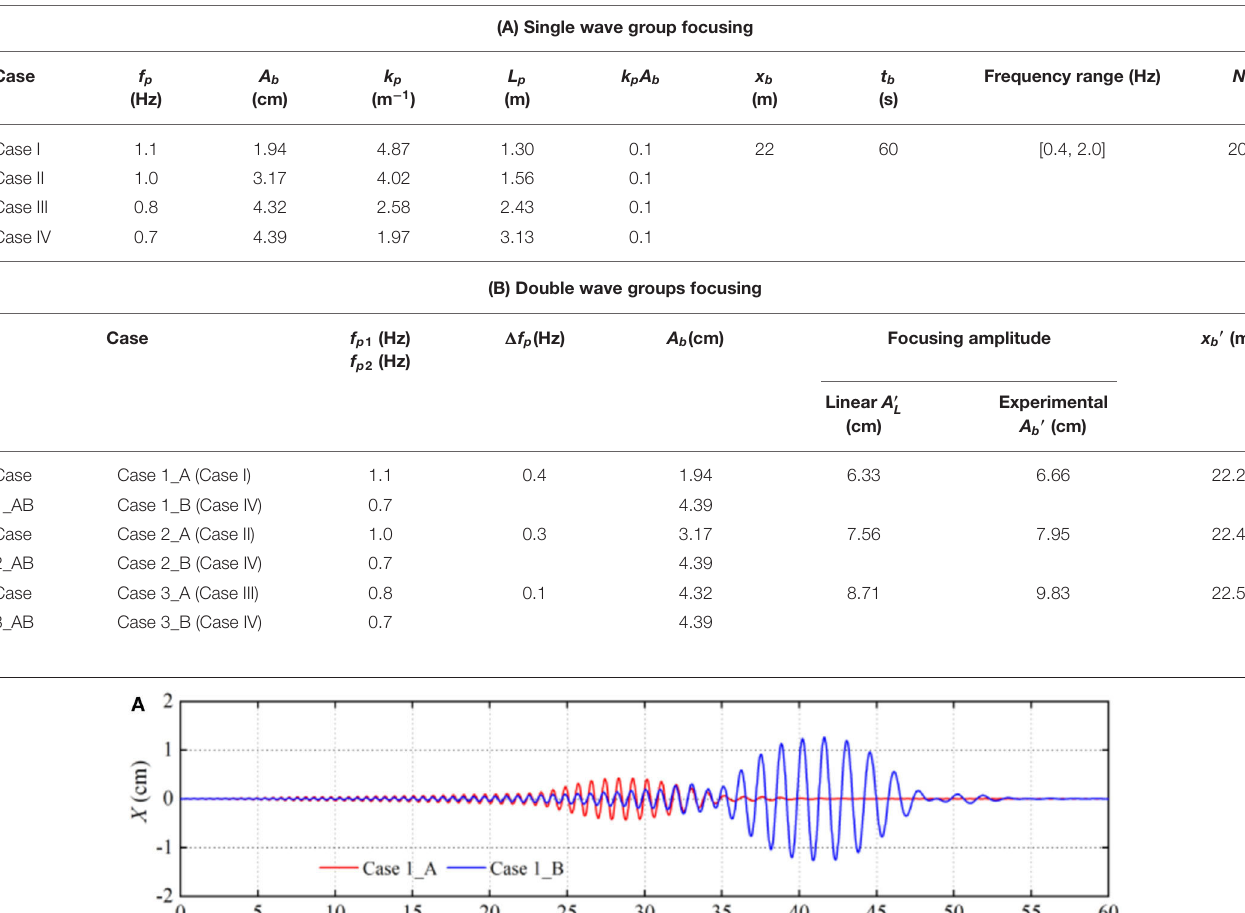
(A) Single wave group focusing